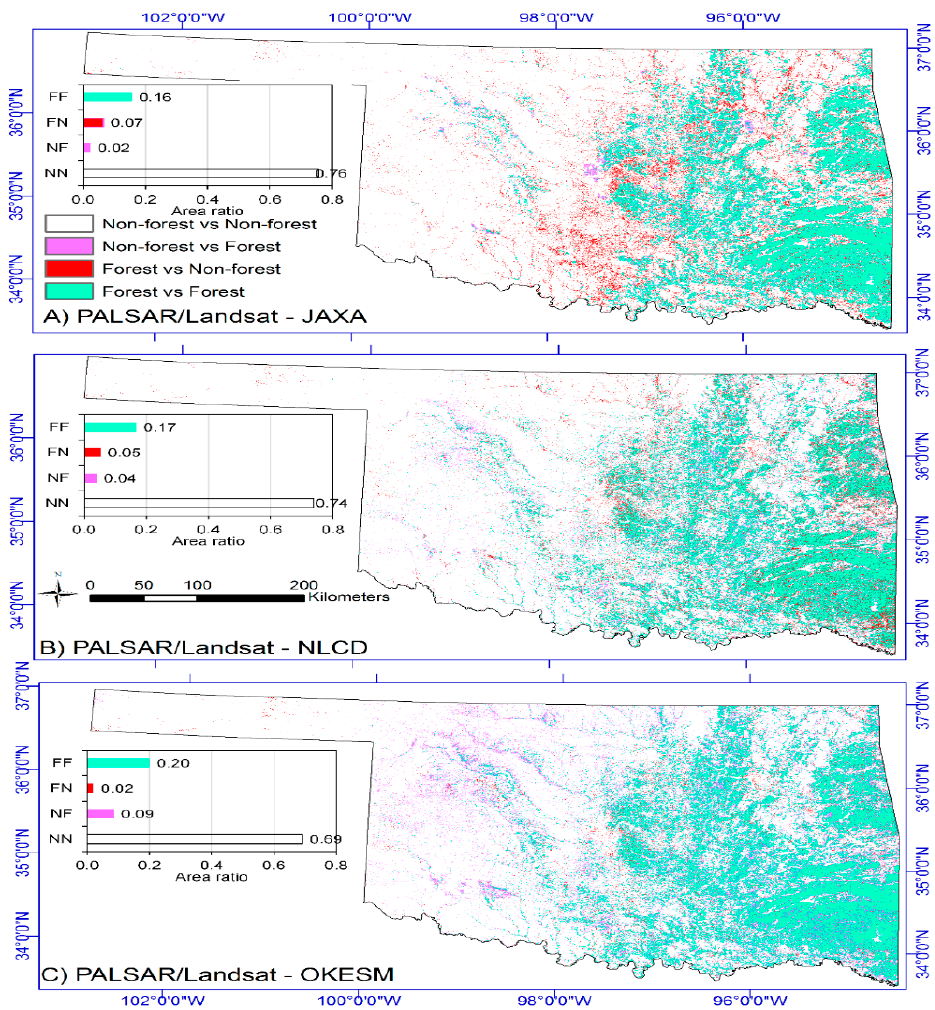
Figure 8. Spatial comparison between the PALSAR/Landsat forest map and ( A ) JAXA forest map; ( B) NLCD2011 forest map; and ( C ) OKESM forest map in 2010.